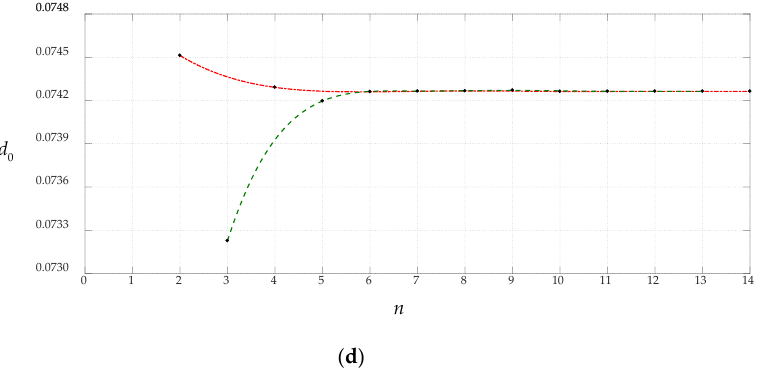
Figure 3. The variations of c 0 , c 1 , α , and d 0 with terms n , where the dash-dotted lines show the convergence trend of the data points of even terms ( n = 2, 4, 6…), the dashed lines show that of odd terms ( n = 3, 5, 7…), and q = 1.8 × 10 −3 MPa: ( a ) the variation of α with n , ( b ) the variation of c 0 with n , ( c ) the variation of c 1 with n , and ( d ) the variation of d 0 with n .